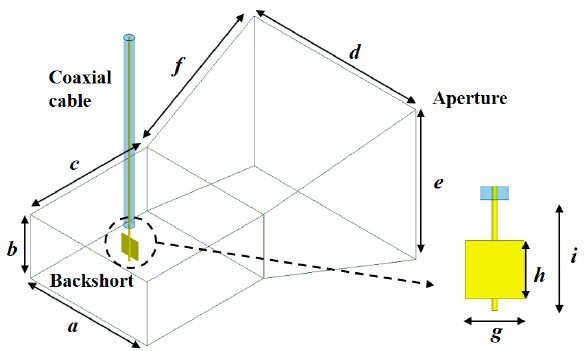
Figure 5. Designed horn antenna with coaxial-feeding.